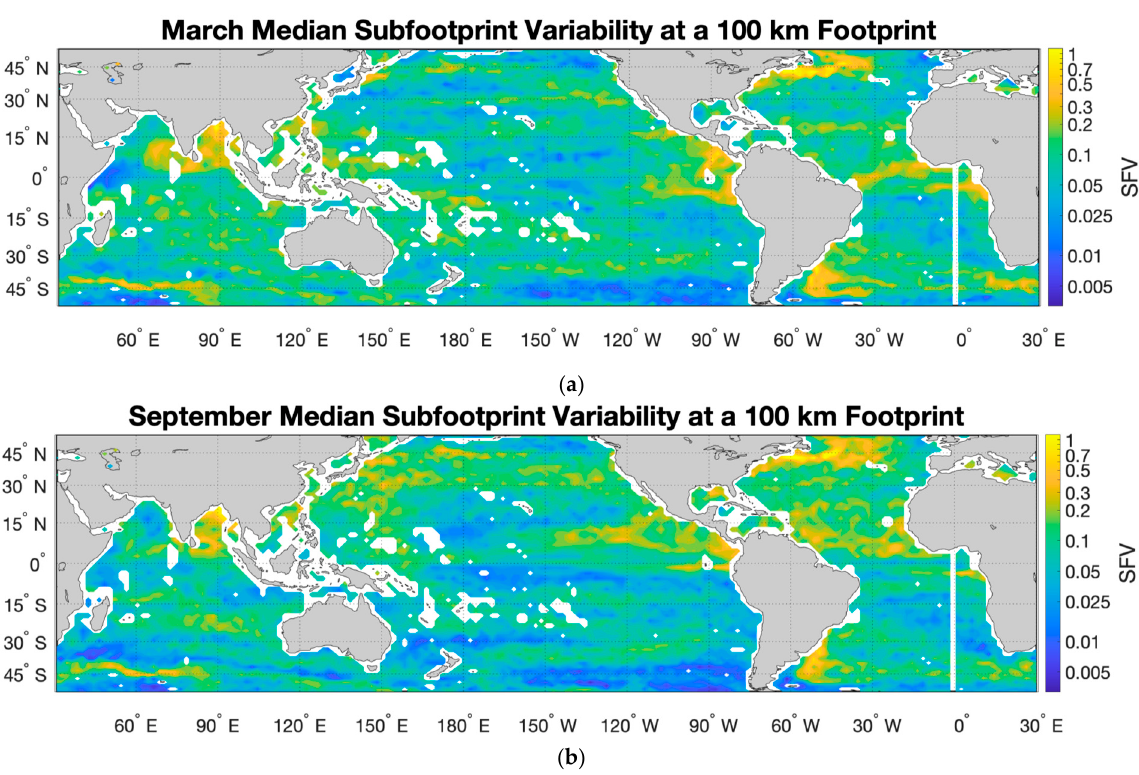
Figure 3. Median SSS SFV, i.e., σ 50 , for a 100 km footprint for the months of ( a ) March and ( b ) September. Unitless color scale is on the right, with the colors scaling with the base 10 logarithm of the SFV.